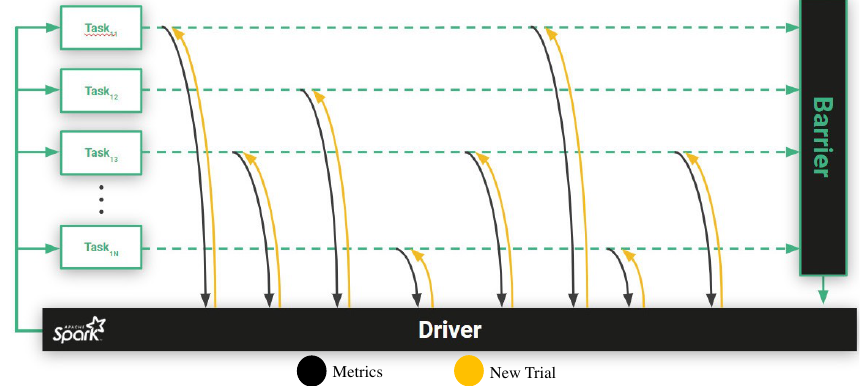
Figure 11. Asynchronous search using the M AGGY